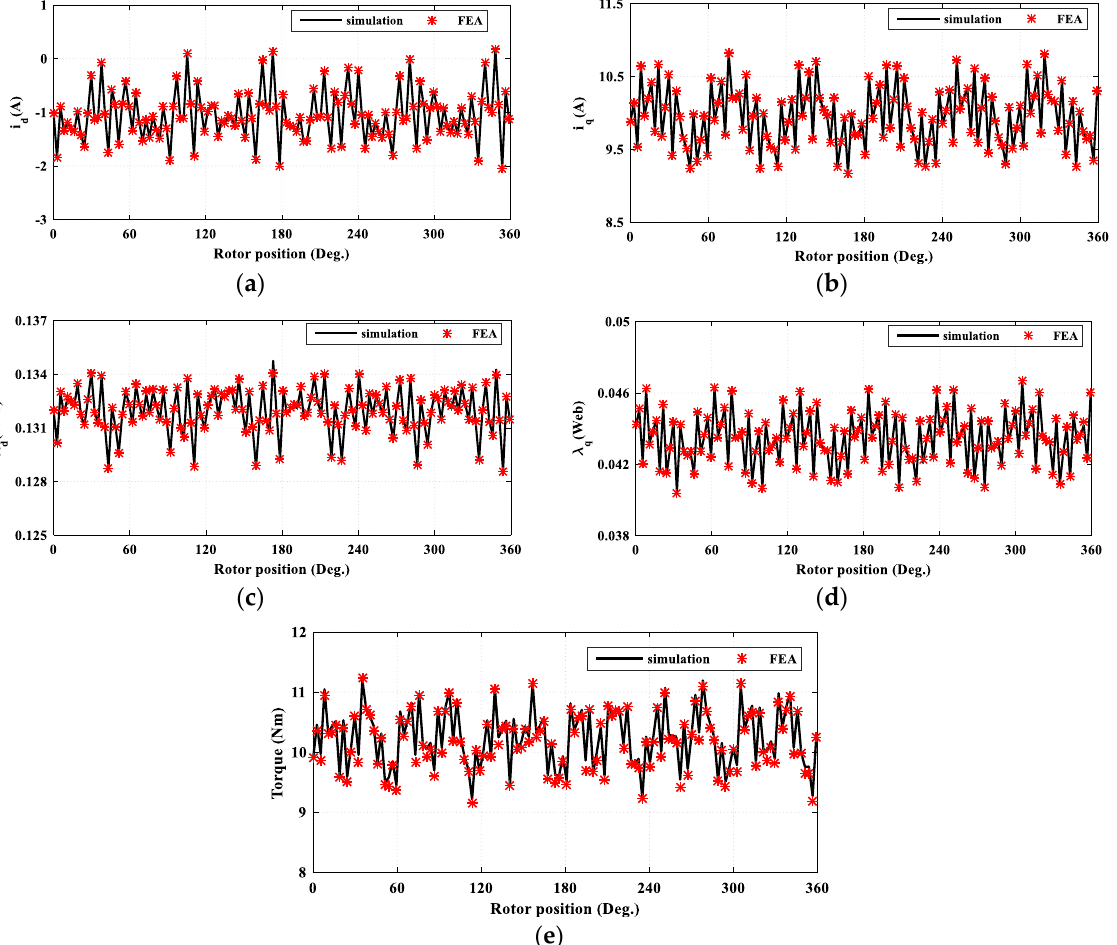
Figure 11. Comparisons of Simulink and FEA: ( a ) d-axis current; ( b ) q-axis current; ( c ) d-axis flux; ( d ) q-axis flux; ( e ) torque.